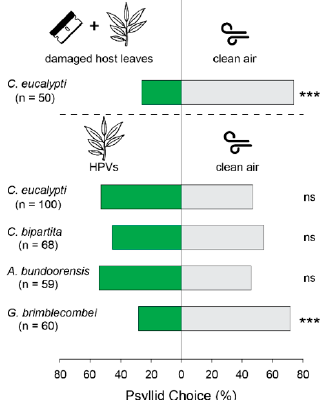
Figure 2. Psyllid responses in the Y-tube olfactometer. Bars above dashed lines show the results of a pilot experiment using damaged E. globulus juvenile leaves as ‘negative control’ to confirm psyllids’ ability to orient in response to odor stimuli under our experimental conditions. Green bars represent attraction to HPVs and grey bars attraction to clean air. (*** = p < 0.001; ns = not significant). ‘n’ under species’ names indicates the number of responders in each experiment.